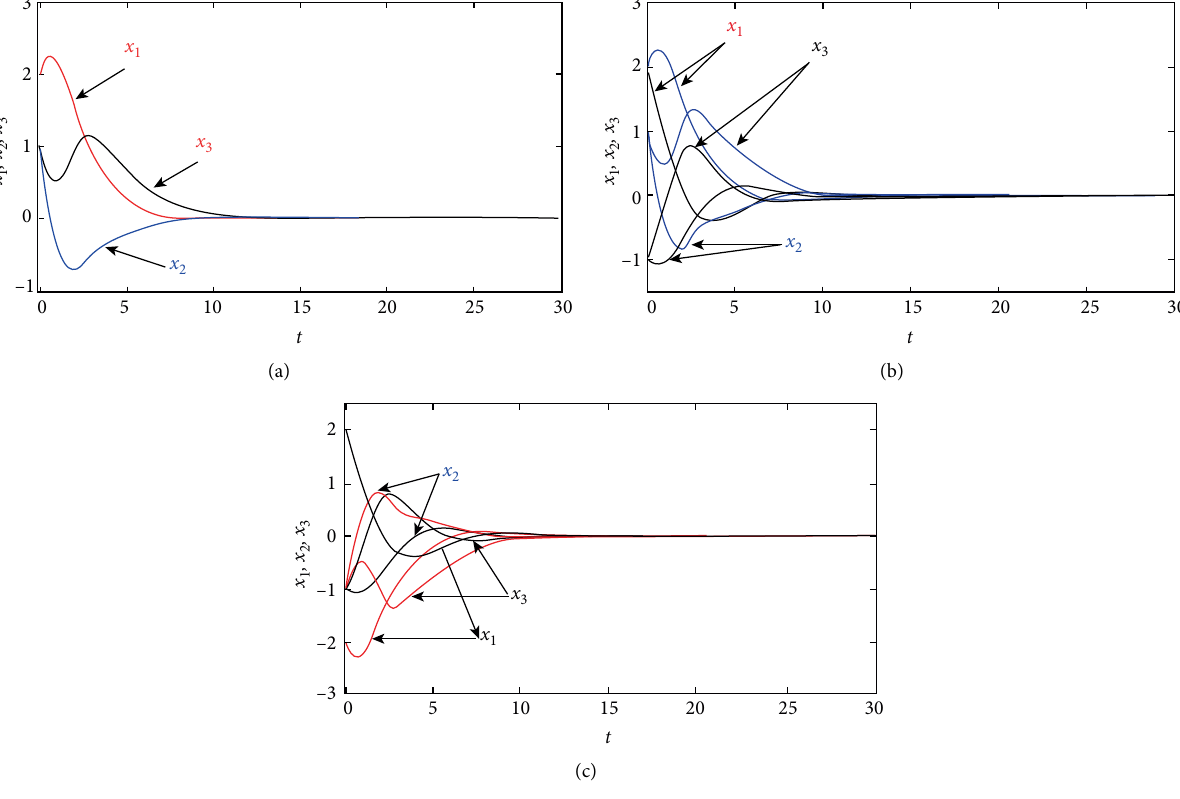
Figure 6: The results of state variables vary with